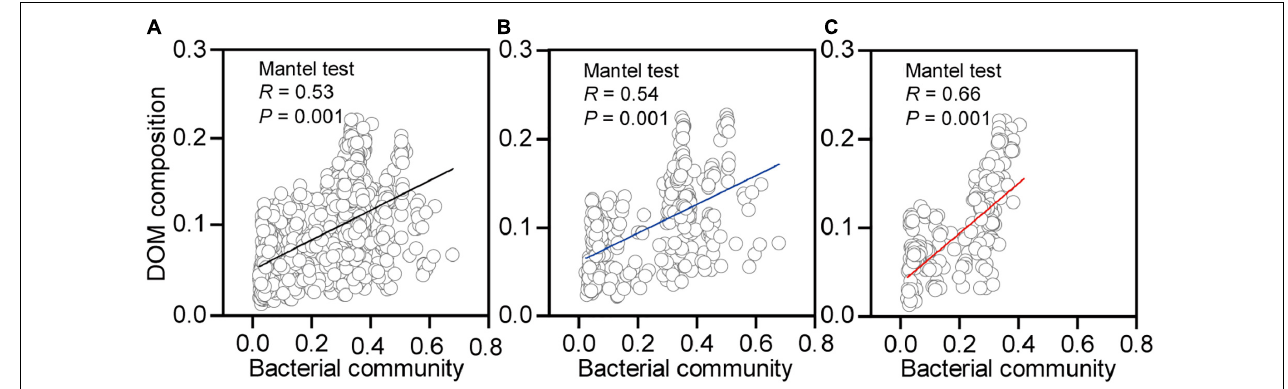
FIGURE 7 | Correlations between bacterial community and dissolved organic matter (DOM) composition for decaying earthworm in both soils (A) , native soil treatment ( B , Beijing), and non-native soil treatment ( C , Xuchang). The Mantel test (9999 permutations) calculated Pearson’s correlation between the Euclidean distance of bacterial community and Bray–Curtis distance of DOM